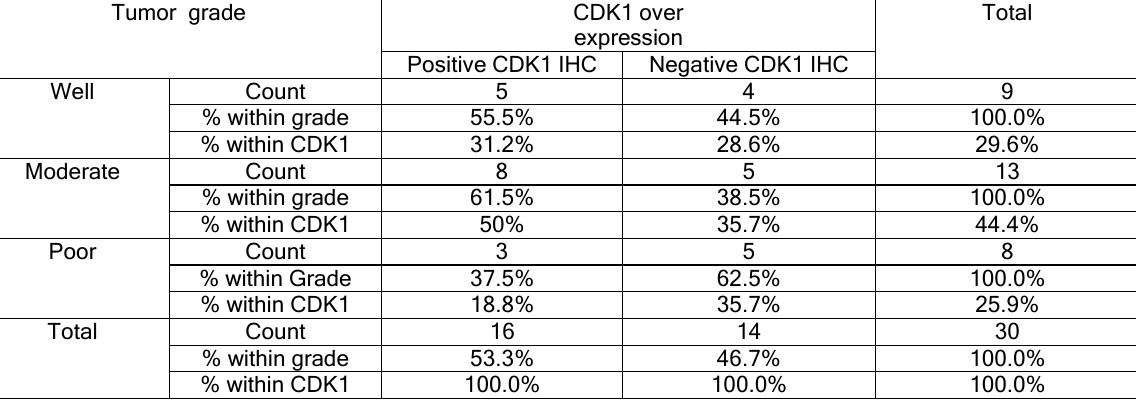
FIGURE 2: Immunohistochemical reactions (IHC) for detection of CDK1 usingspecific primary antibodies for CDK1and biotinylated -labeled anti-CDK1;Stained with HRP/DAB (brown) and counter stained by hematoxyline (Blue).A. Invasive breast ductal carcinoma with negative CDK1–IHC reaction(40X). B. Invasive breast cancer with positive CDK1–IHC reaction that revealed high score and strong signal intensity (40X). Table (6):The distribution of CDK1 expression tests results according to tumor grade/ differentiation of breast carcinoma . Tumor